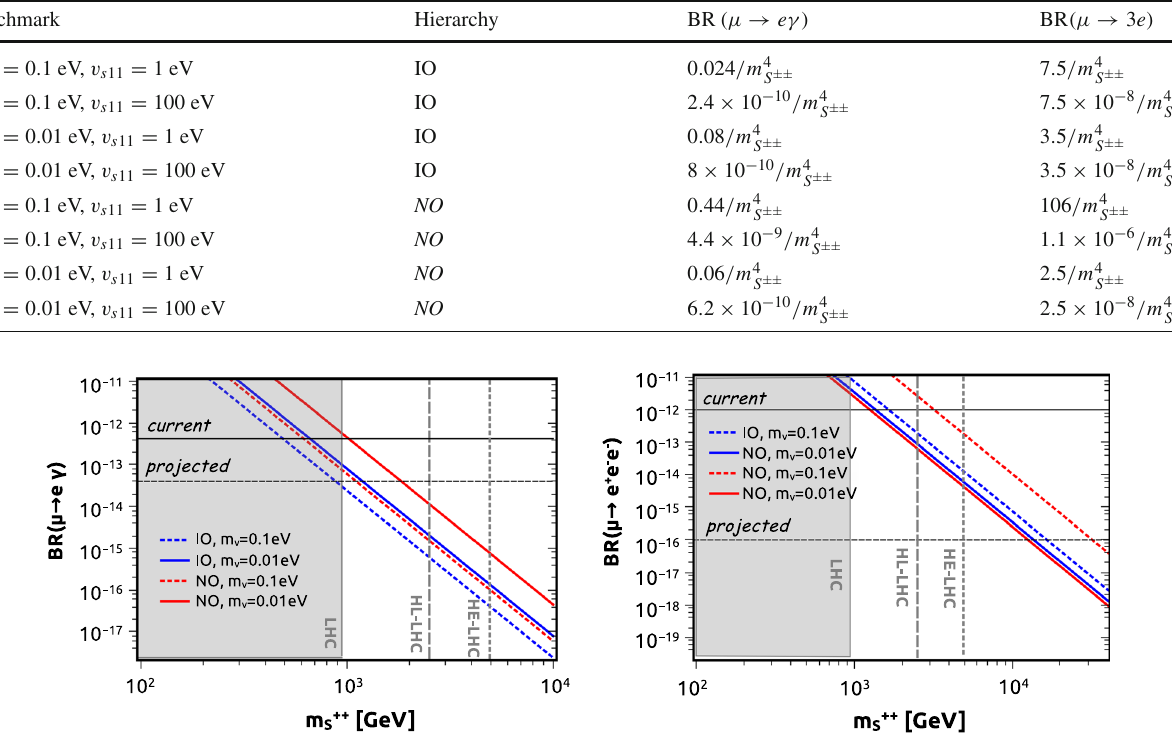
Table 2 Table with the theoretical predictions for the μ → e γ and μ → 3 e decay for the type I + I I seesaw setup encompassing normal (NO) and inverted (IO) mass ordering. We highlight that the mass of